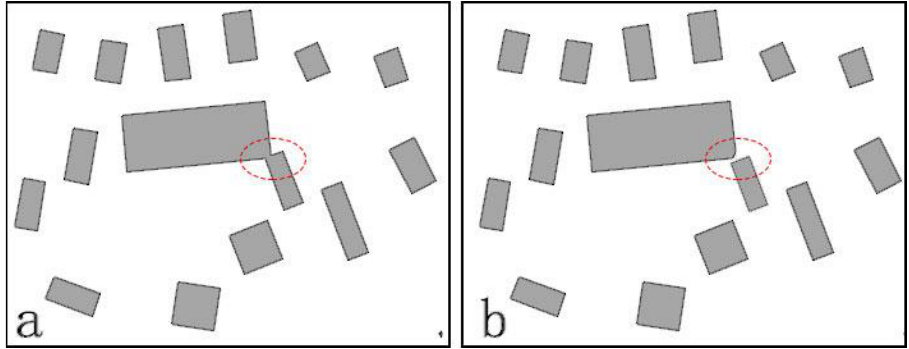
Figure 16. Consider topology and legibility. ( a ) Original topology error map. ( b ) Topology correction results.